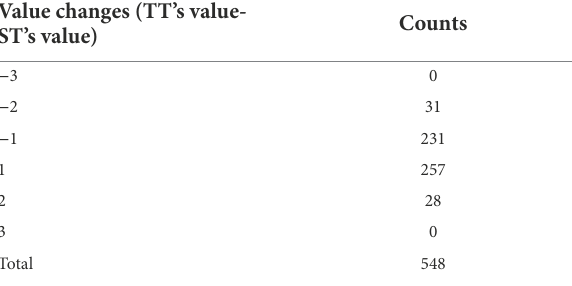
TABLE 10 Modal verbs’ value change between ST and